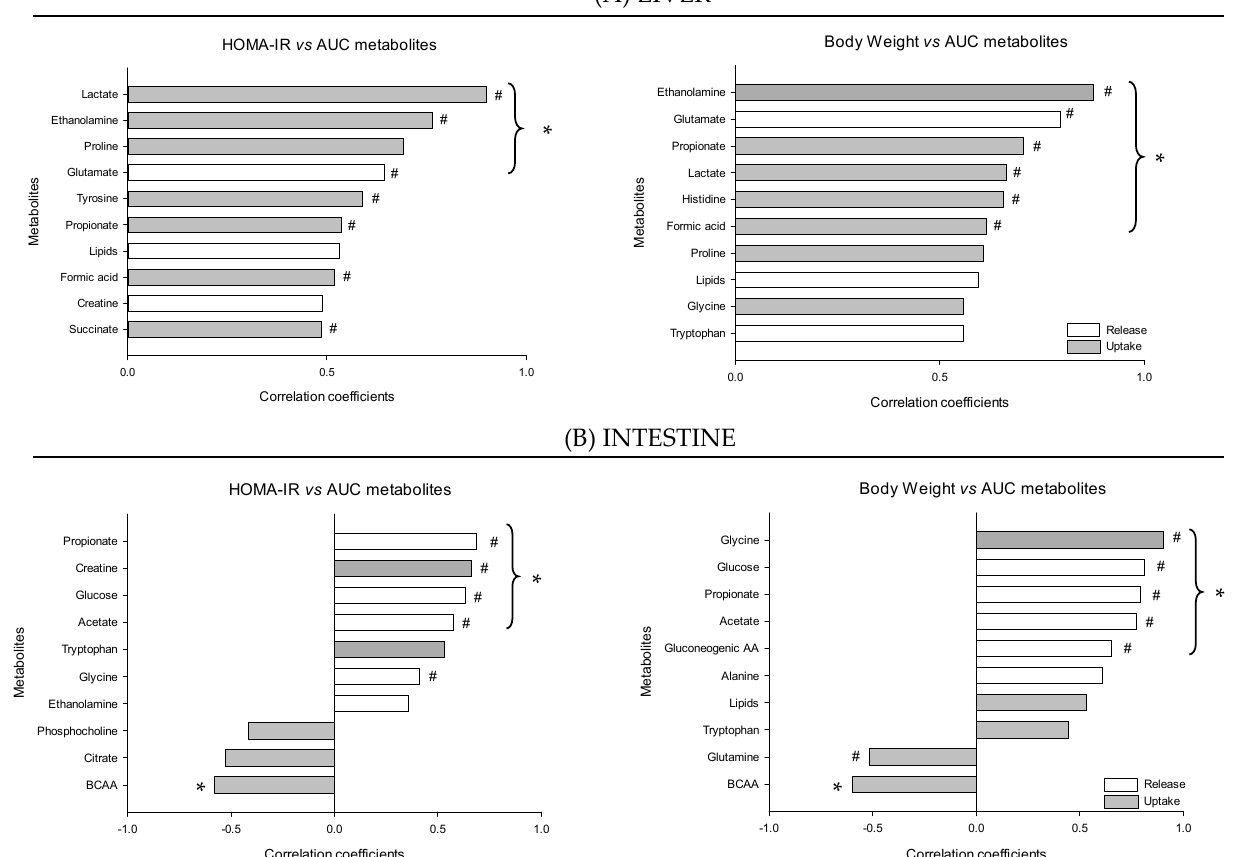
Figure 10. Pearson correlations performed at the liver ( A ) or intestine ( B ) level between the HOMA-IR or the BW and the AUC exchange values for each metabolite to identify metabolites that are release or take up in greater / smaller amount depending on the HOMA-IR or BW. Correlations were computed using the absolute values of the exchange AUC at both D0 and D60 in order to consider in a similar way the release (negative AUC values) and uptake (positive AUC values) exchanges. Metabolites for which the absolute value of the AUC did not reflect the change in the exchange between D0 and D60 because the AUC value was switching sign (i.e., switching from uptake to release or from release to uptake) between D0 and D60 were excluded from the analysis. *, significant correlation between a given metabolite and health outcome (HOMA-IR or obesity), p < 0.05; #, AUC significantly di ff erent from D0, p < 0.05. The figures are showing the top10 metabolites. See the supplemental Tables S3–S6 (Supplementary Materials) for more